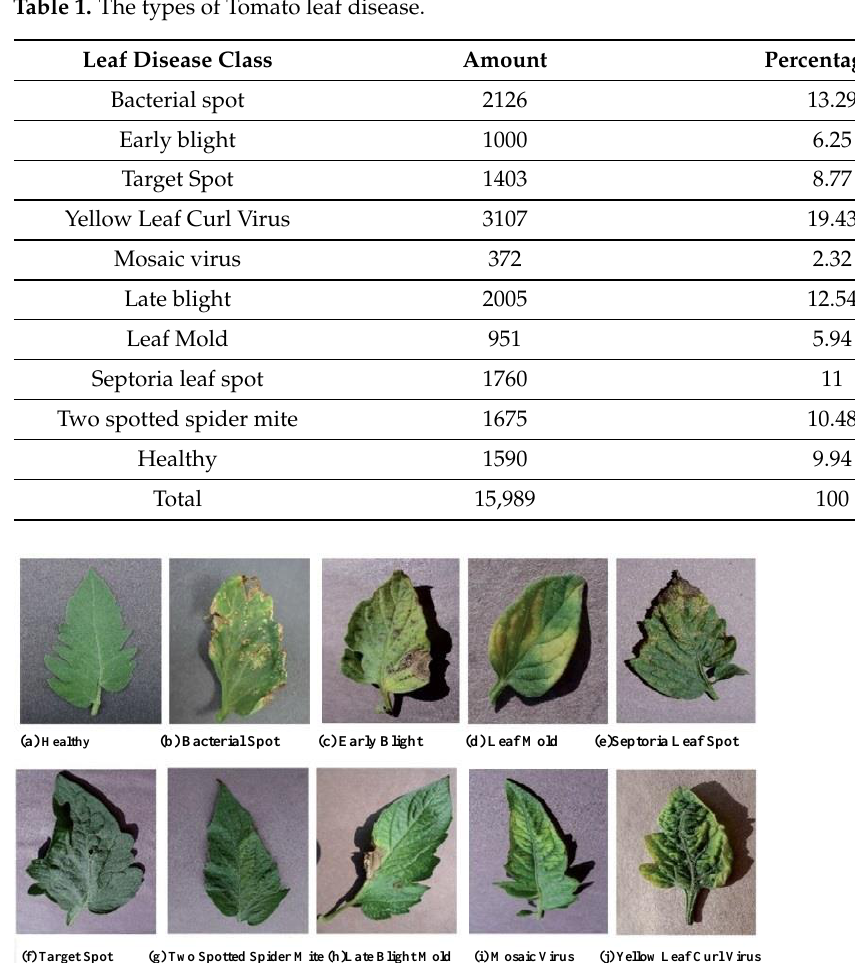
Table 1. The types of Tomato leaf disease.